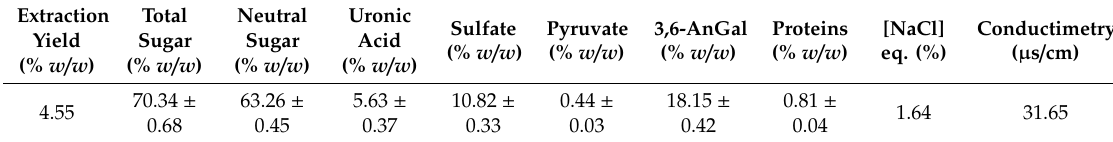
Table 1. Global composition of